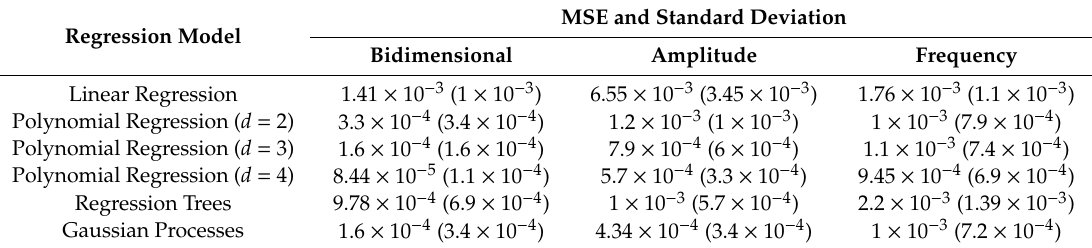
Table 2. Mean and standard deviation of the mean squared error (MSE) using the different techniques, for N2A cells.